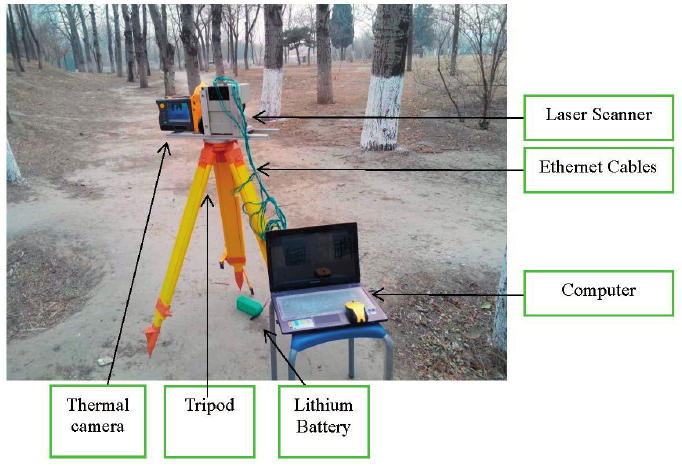
Figure 1. The measurement equipment includes sensor equipment fixed on the tripod platform as well as the data acquisition PC and lithium batteries providing 24 V for the system. The experiment is used in a birch